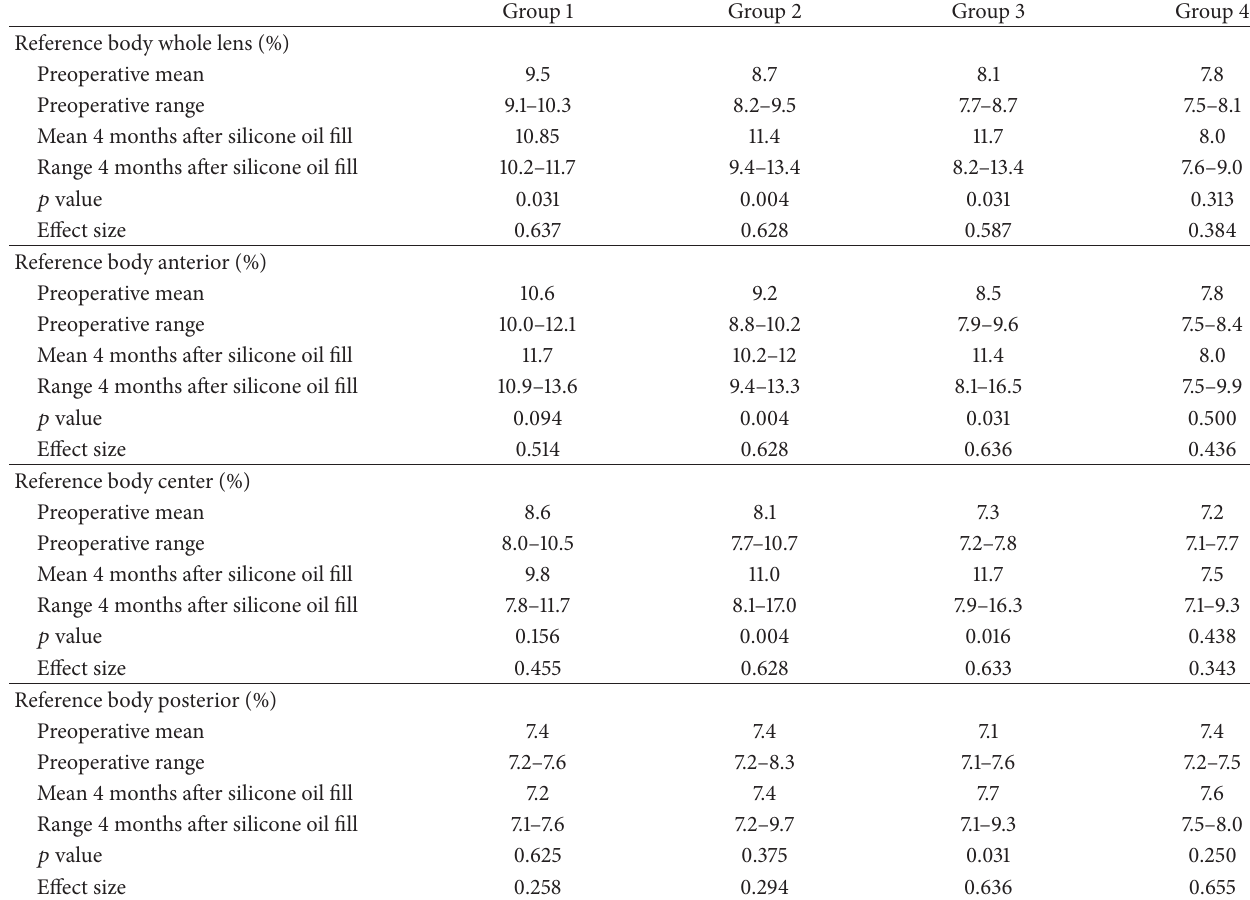
Table 2: Change in lens